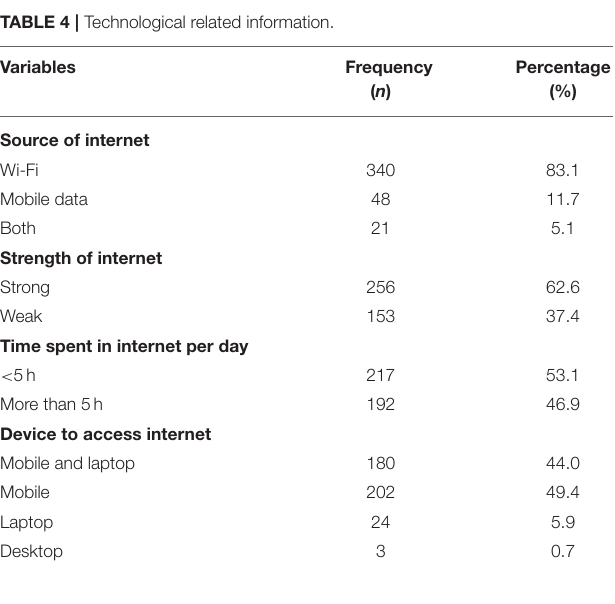
TABLE 4 | Technological related information.